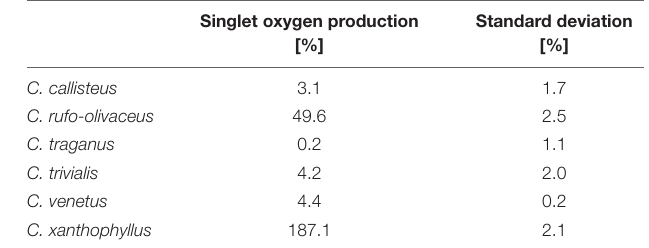
TABLE 4 | Results of the dimethyl anthracene (DMA) assay (blue light irradiation TABLE 3 | Initial weight of biomaterial of Cortinarius species and yield of extracts. relative to phenalene-1-one). Biomaterial [mg] Yield of extract Singlet oxygen production [mg, (%)]